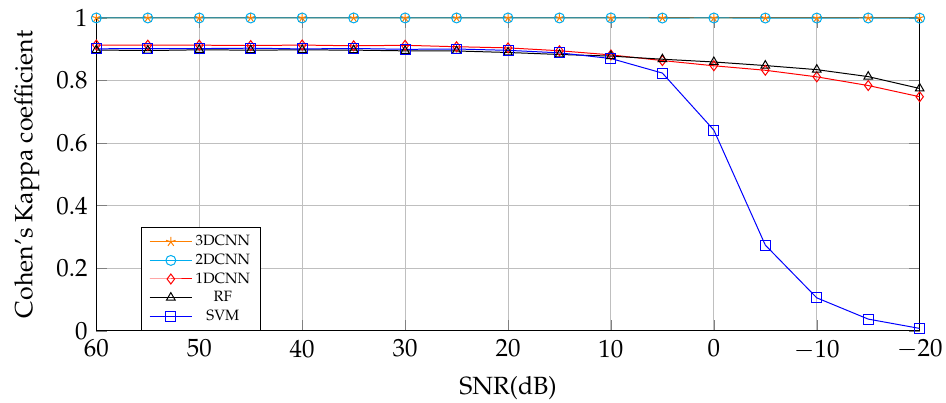
Figure 13. Salinas. Cohen’s Kappa coefficient obtained by different classifiers for SAL HSI compressed with TKD to 40 tensorial bands training with 10% of TS. The best performance is achieved by 3DCNN and 2DCNN, then 1DCNN, RF, and SVM show aproximately the same performance above 10 dB, but, below that, SVM was shown to be the